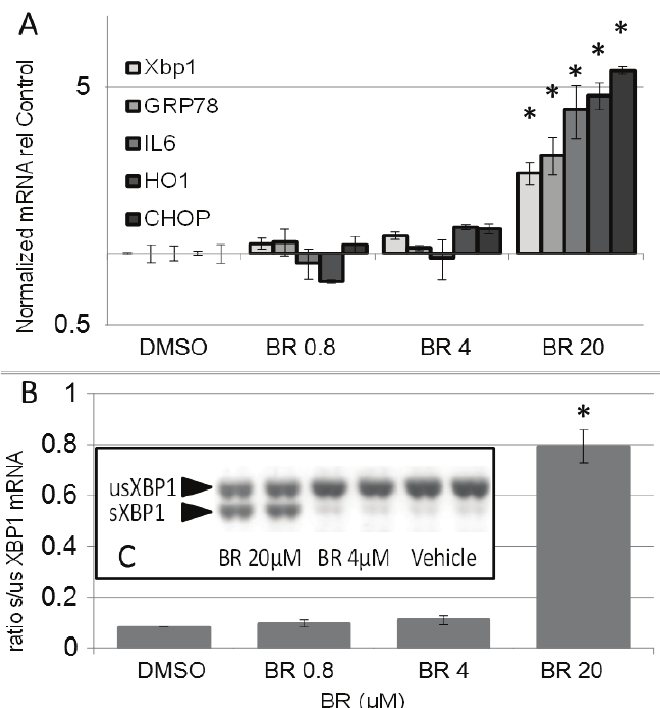
Figure 8. Physiologic range of BR induces ER stress response in BRL 3A cells. ( A ) Cells were treated with vehicle (DMSO) or BR in the concentrations indicated, and incubated for 8 h. RNA was extracted and expression of cell stress markers X-Box binding protein 1